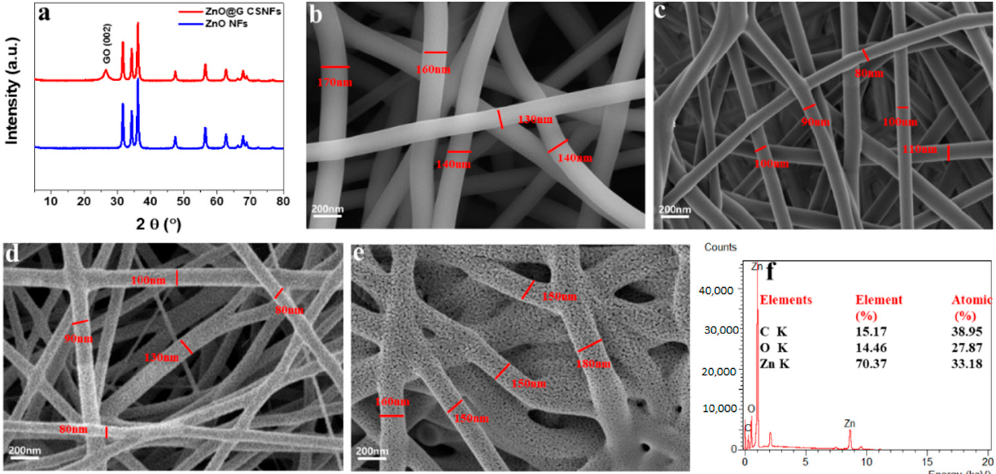
Figure 1. XRD patterns of ZnO NFs and ZnO@G CSNFs ( a ); FE-SEM image of ZnAc/PVP/G NFs ( b ); FE-SEM image of 350 °C/3 h annealed ZnAc/PVP/G CSNFs ( c ); FE-SEM image of 450 °C/3 h annealed ZnAc/PVP/G CSNFs ( d ); FE-SEM image of 550 °C/3 h annealed ZnAc/PVP/G CSNFs ( e ); and SEM-EDS of ZnO@G CSNFs ( f ).